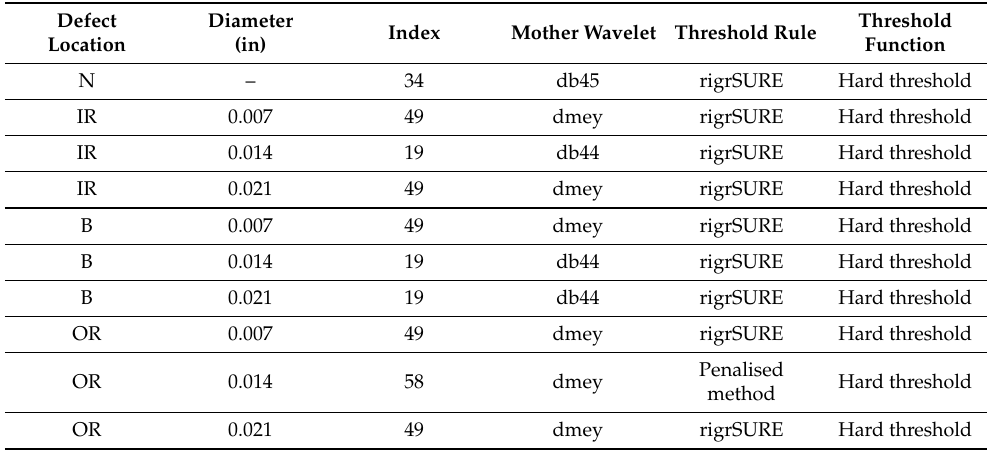
Table 4. Summary of denoising parameters that maximise TO for different defect locations and